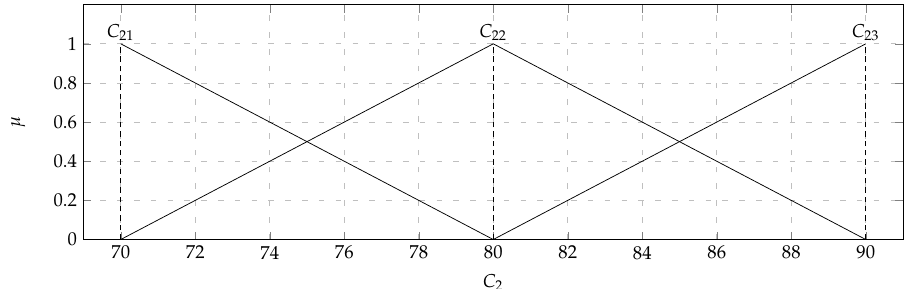
Figure 5. Visualization of Average damage per round ( C 2 ) and triangular fuzzy numbers 70 ( C 21 ), 80 ( C 22 ), and 90 ( C 23